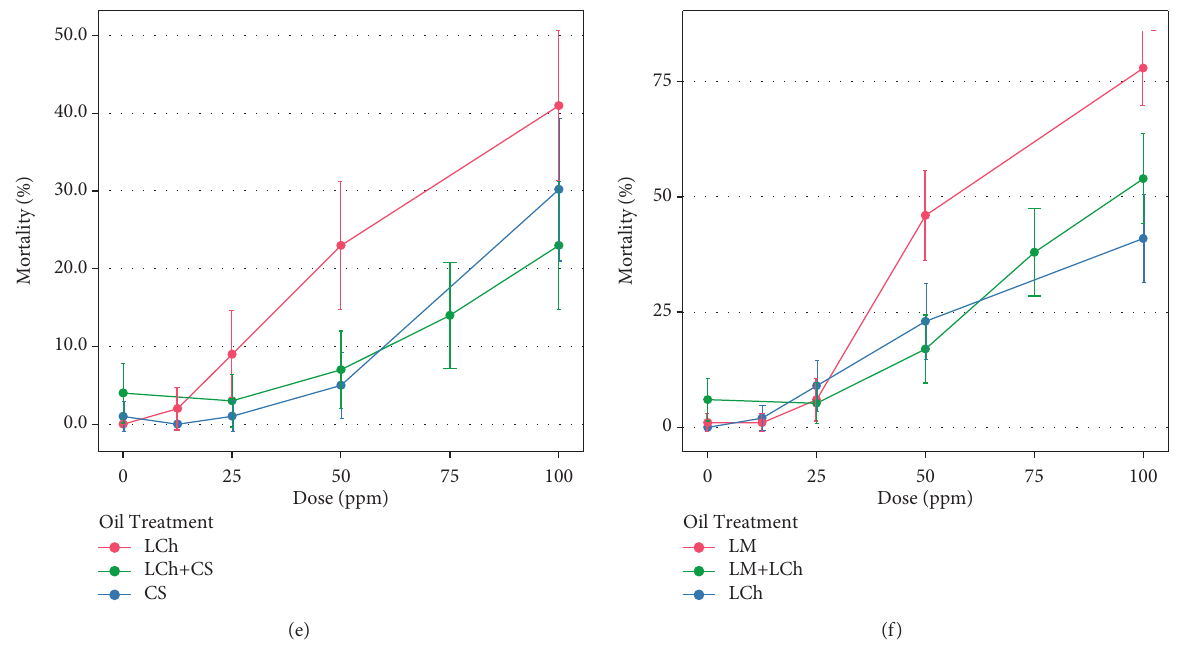
Figure 1: Larval mortality rate with confidence limits of the 3 rd –4 th instar larvae of Anopheles funestus following exposure to various concentrations of essential oils and their mixtures. LM : Lippia multiflora ; LCh : Lippia chevalieri ; LCa : Lantana camara ; CS : Cymbopogon schoenanthus